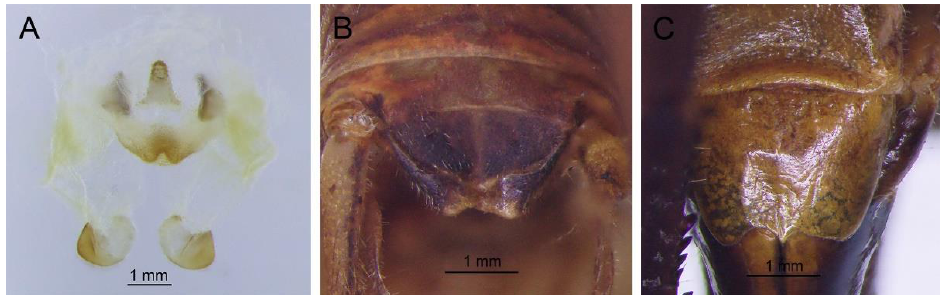
paired lateral sclerites, quadrangular, apical area not divided; dorsal lateral lobes little longer than dorsal median lobe, basal area broad, gradually narrowing to apices, apical area sclerotized, hooked; ventral median lobe and ventral lateral lobes very short. Sub- genital plate quadrangular, wide, posterior margin straight. Figure 19. Homotachycines trapezialis comb. nov. (type specimens), male: ( A ) genitalia in dorsal view; Female: Unknown. ( B ) apex of abdomen in dorsal view; female: ( C ) subgenital plate in ventral view. black stripes, apical areas of all femora black. Homotachycines triangulus Zhu & Shi sp. nov.